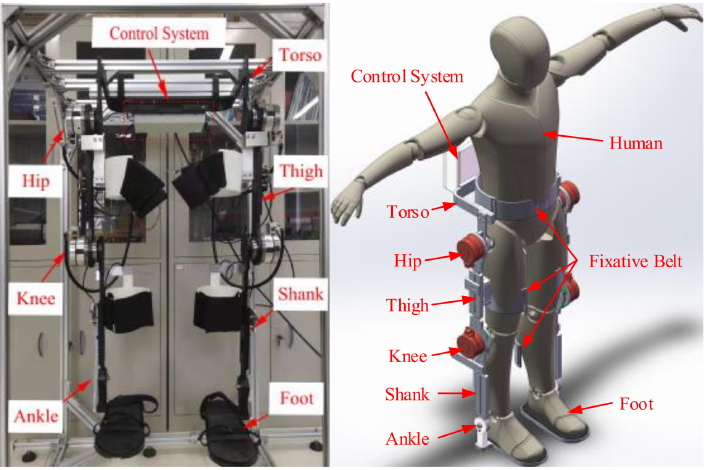
Figure 1. The prototype of the lower limb rehabilitation exoskeleton robot.